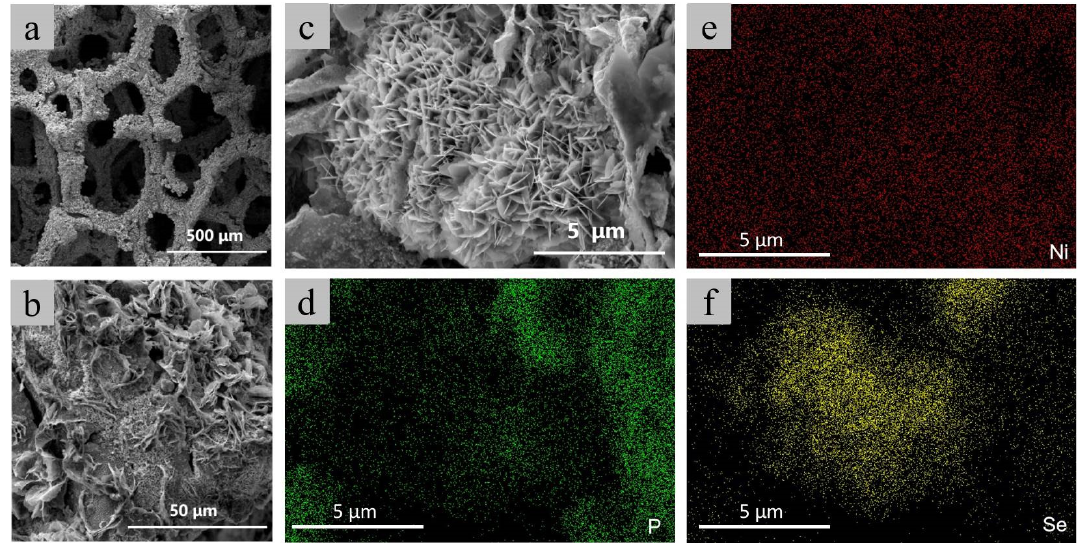
Figure 2. Low magnification SEM images ( a – c ) and corresponding elemental distributions of Ni 5 P 4 - Se composites ( d – f ). composites ( d – f